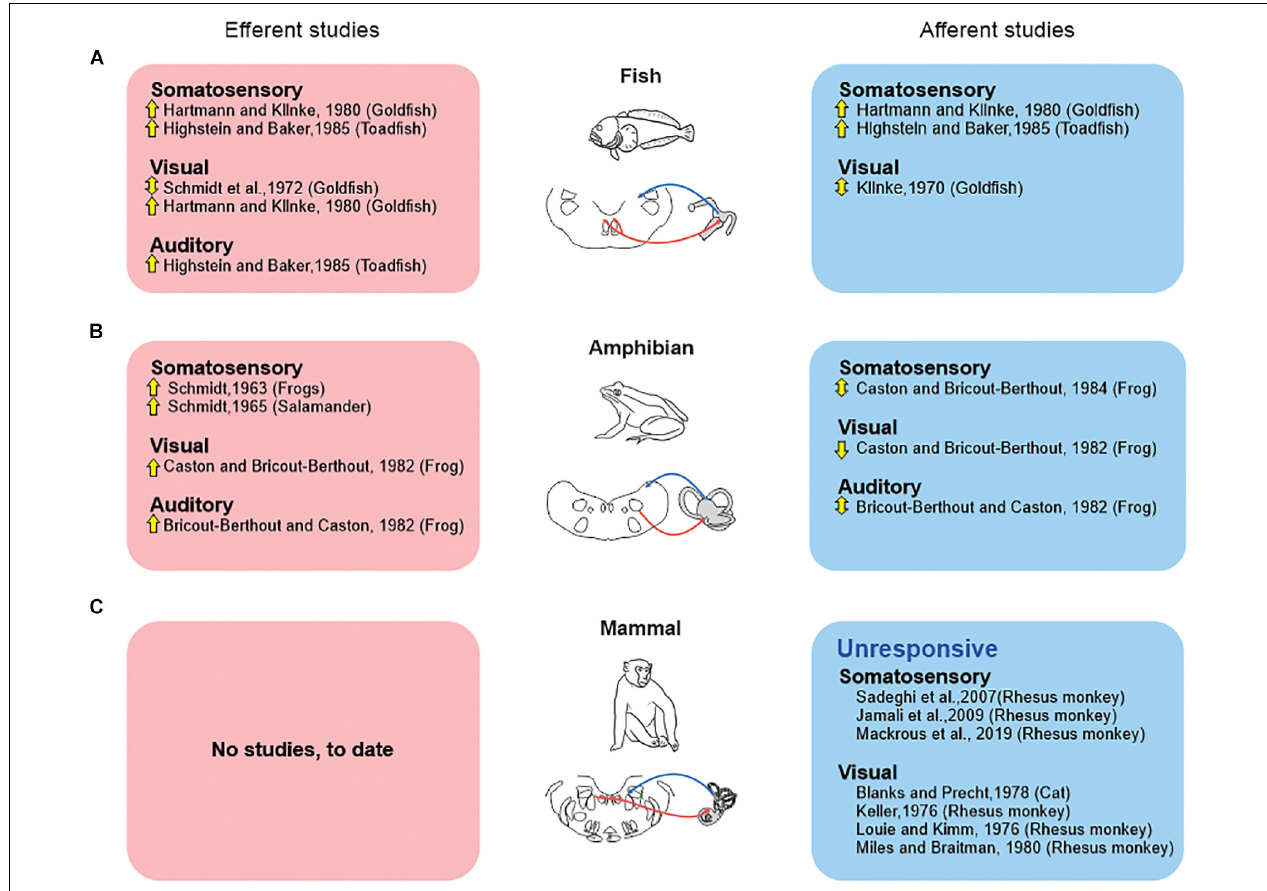
FIGURE 2 | Extra-vestibular sensory systems (somatosensory, visual, auditory) have been reported to alter peripheral vestibular processing in fish and amphibians but not in mammals. Studies that directly recorded from the vestibular efferent pathway (red boxes), vs. those that recorded efferent-mediated effects in vestibular afferents (blue boxes) are shown for studies in fish (A) , amphibians (B) , and mammals (C) . Symbols : up arrows: excitation; down arrows: inhibition; up-down arrows: both excitation and inhibition.